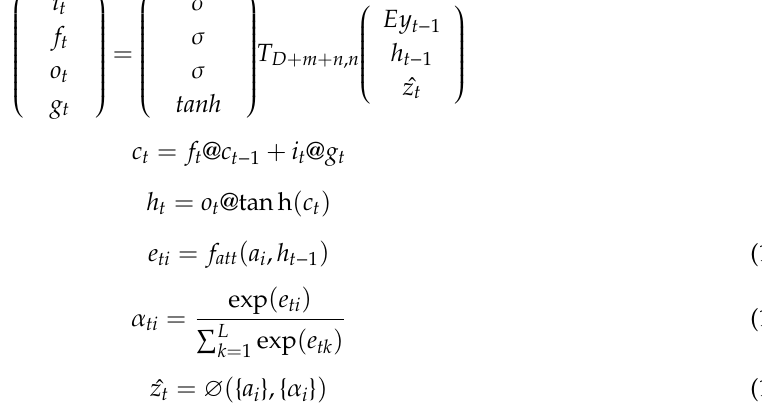
Figure 7. The structure of the RNN ( left ) and its application in processing time series data ( right ).